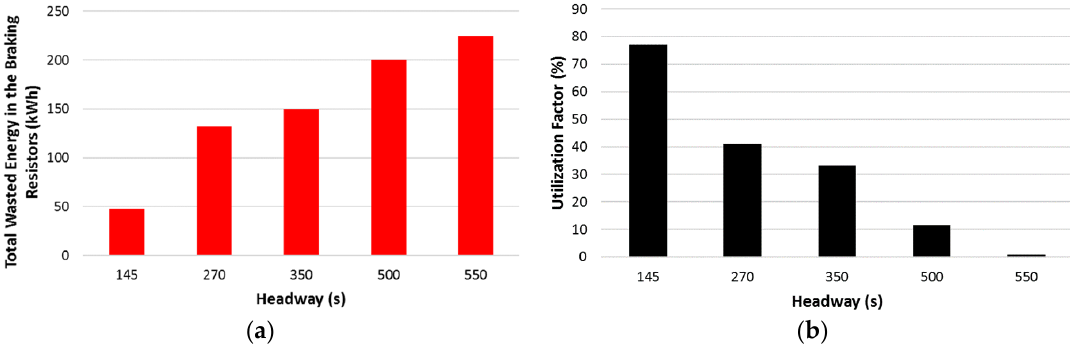
Figure 20. The impact of changing the headway on: ( a ) The total energy dissipated through the onboard braking resistors; and ( b ) The receptivity of the line to accept the available regenerative